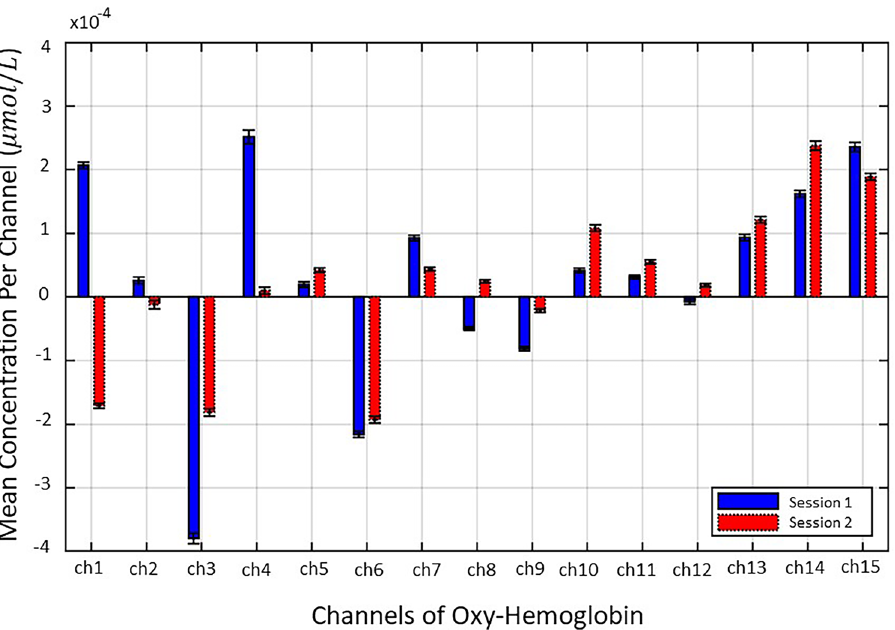
Figure 3. Average concentration of HbO for each channel. The blue bars are Session 1 and red bars refer to Session 2. Error bars indicate standard error of the mean (s.e.m) to estimate the variability of the mean concentration of HbO per channel. Stars indicate a statistically significant differences in mean concentration of HbO between Session 1 and Session 2 conditions ( ∗∗∗ < 0.001 ; ∗∗ p < 0.01 ) . In all channels, hemodynamic differences between the two sessions are markedly different. This suggests the possibility of judging people’s impulse buying